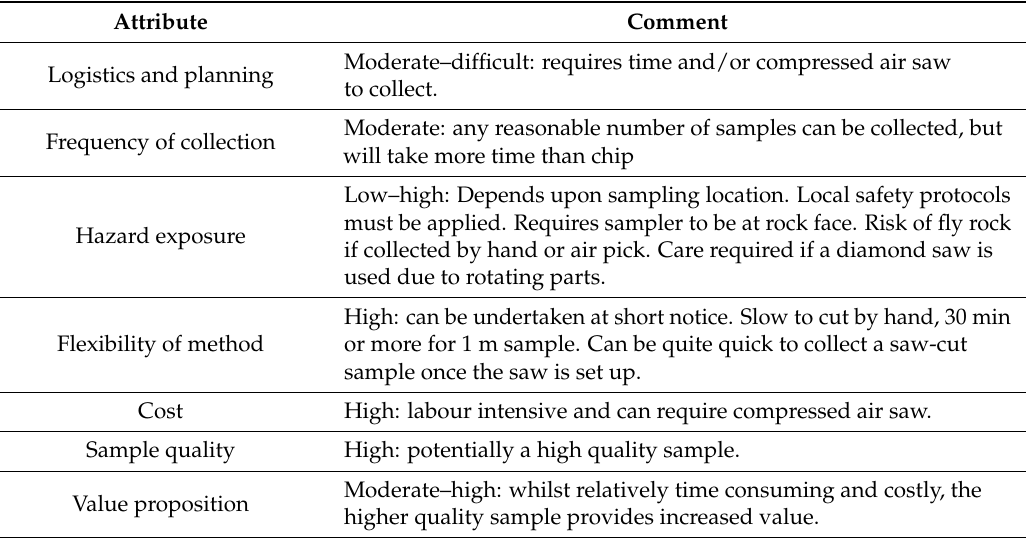
Table 11. Channel sampling